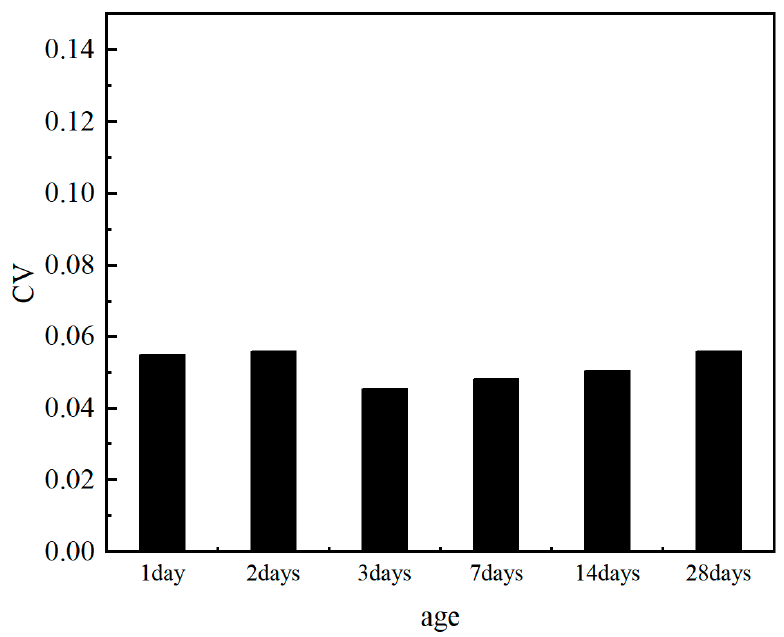
Figure 7. The coefficient of variation in different ages.